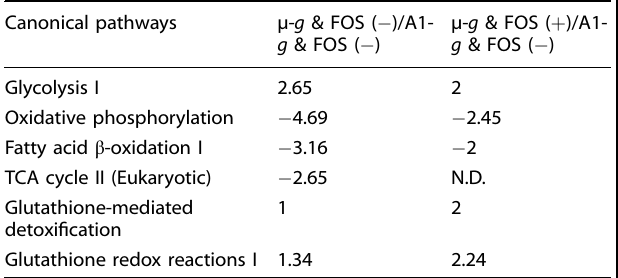
The protein abundance pro fi les in Sol muscles of the groups exposed to µ- g with and without FOS ingestion were individually compared with that of